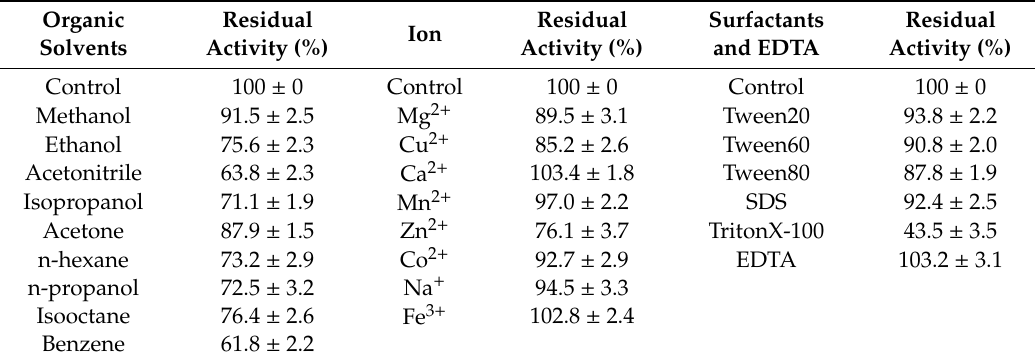
Table 2. E ff ects of additives on Est M160K